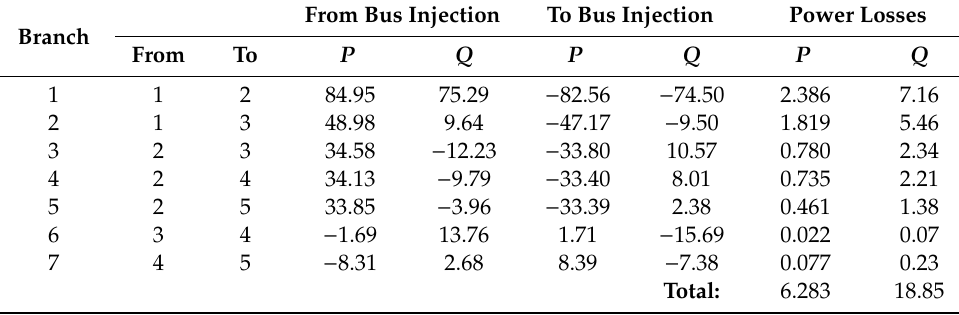
Table A9. Results of the mixed AC / DC PF calculations in Case 3. AC branch